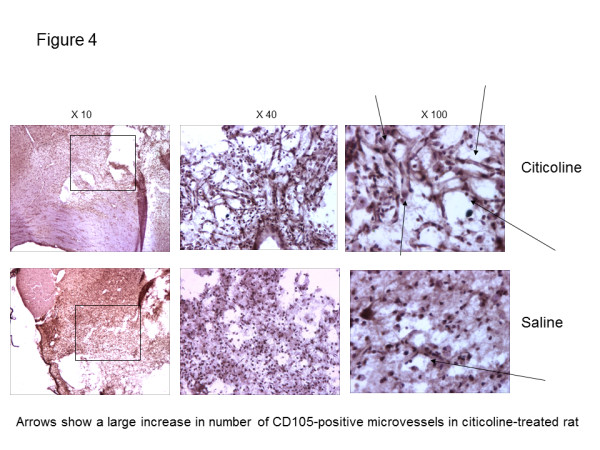
Immunohistochemical staining for CD105 demonstrated the presence of significantly more active microvessels in stroke regions of rats treated with citicoline following MCAO. Treatment with citicoline significantly increased the number of CD105-positive microvessels in the peri-infarcted and infarcted regions following transient rat MCAO after 21 days. The figure shows citicoline-treated animals (top row) versus saline treated controls (bottom row). Sections were immunohistochemically stained and developed using DAB (brown). Arrows point to CD105-positively stained microvessels which were consistently more numerous in each animal studied following citicoline treatment (n = 3; p = 0.021).